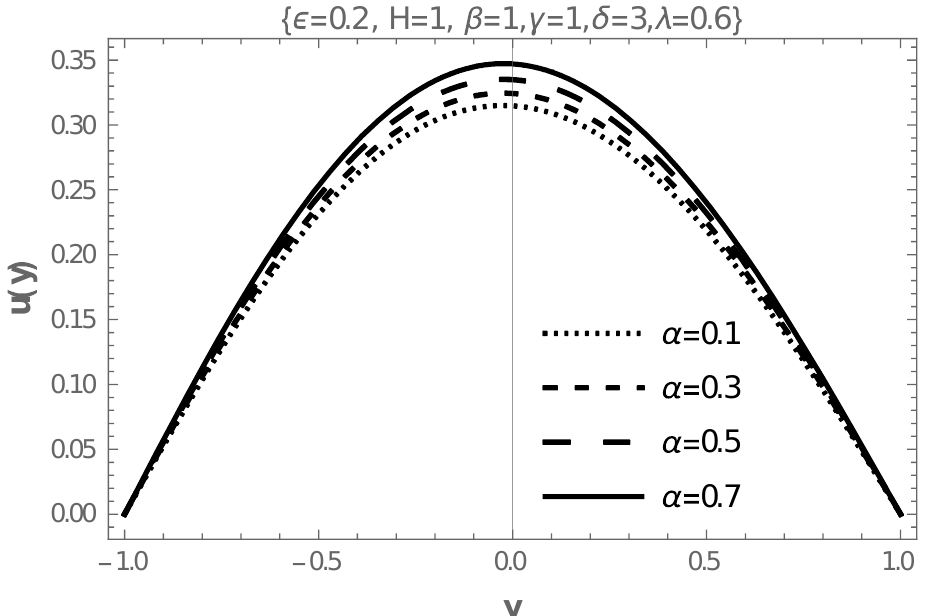
Figure 2. Velocity profile with viscosity variation parameter ( α ).